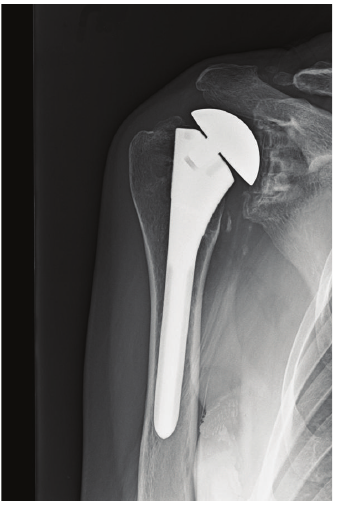
Figure 3: Anterior-posterior radiograph of the patient’s right shoulder taken eight months after the revision of the humeral head (16 months after the index TSA). Narrowing of the distance between the acromion and the humeral head seen in this image is suggestive of weakness or a tear of the superior rotator cuff [28].